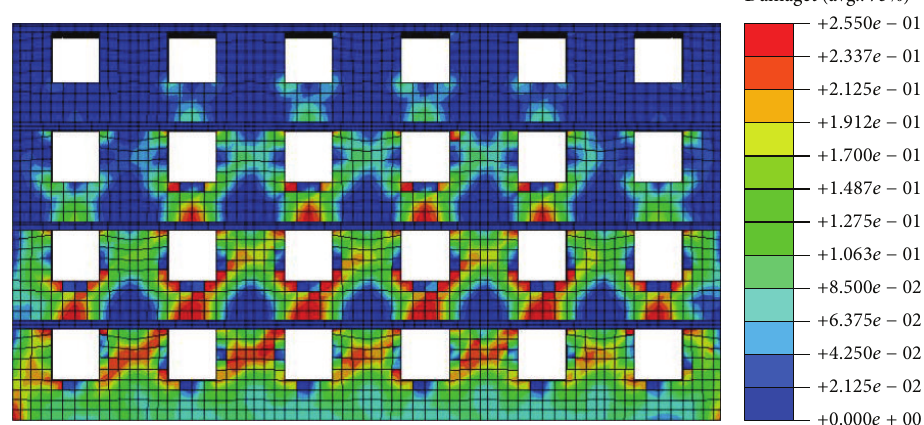
Figure 19: Tension crack damage cloud of model 4 under Lixian County ground